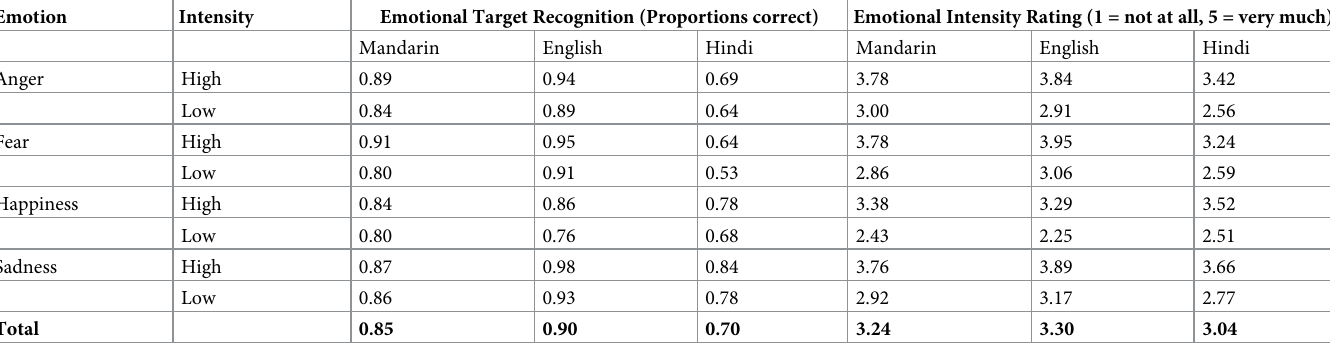
Data show the mean recognition accuracy and perceived intensity of emotional expression judged by native listeners of each language based on earlier validation studies [26, 35].